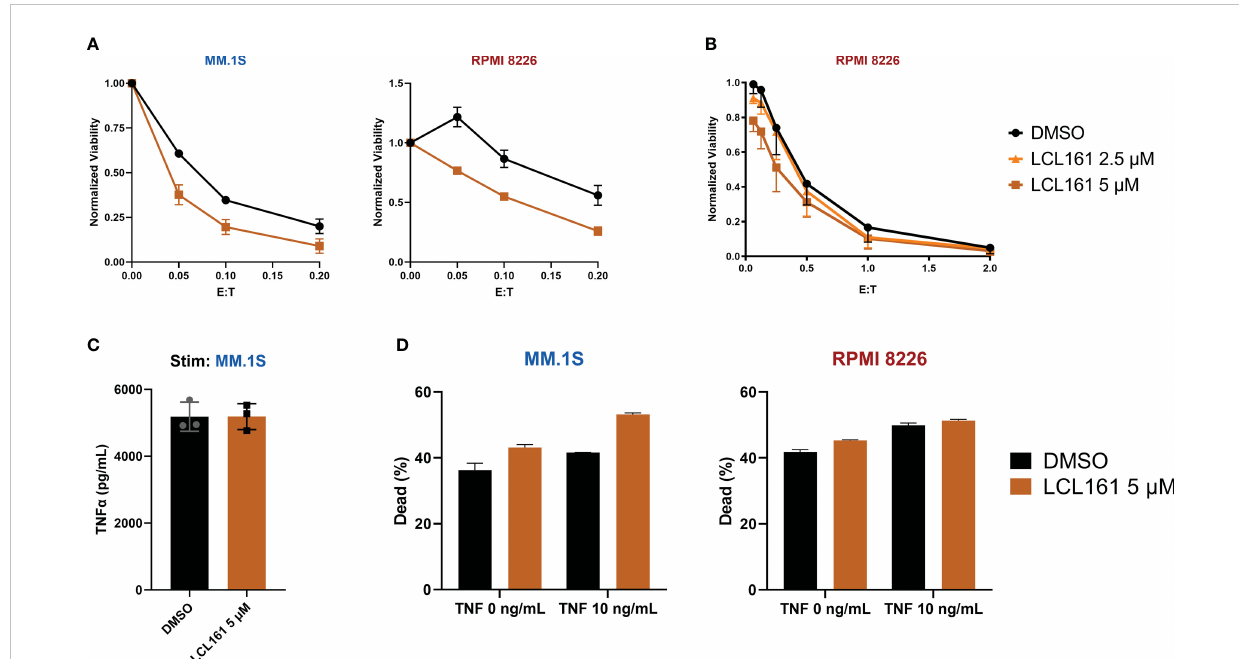
FIGURE 5 LCL161 sensitizes multiple myeloma cells to T cell cytotoxicity at higher doses. (A) 5x10 5 tumor cells were co-cultured with TAC T cells and 5 m M LCL161 or vehicle, in biological triplicate at various E:T for 24 hrs. After co-culture, cytotoxicity was measured through fl ow analysis and normalized to tumor-only controls; data shown as mean and SD. Data were generated with T cells from 3 different donors (L5, L6, L9) run independently in 1 experiment (B) . Luciferase-based cytotoxicity assay of TAC T cells co-cultured with effLuc+ myeloma cell lines for 48 hours in the presence of vehicle or LCL161. Samples were run in triplicate and normalized to tumor-only cell controls; data shown as mean and SEM. Data were generated with T cells from 3 different donors (L6, L7, L9) run independently in 1 experiment. (C) TAC T cells were stimulated with MM.1S cells at an E:T ratio of 1:1 in the presence of either DMSO or LCL161 for 24 hours and TNF a levels were measured in the supernatant. The data re fl ects technical triplicates (D) Multiple myeloma cell lines were incubated with DMSO or LCL161, in the presence of TNF a for 48 hrs. Cells were harvested, stained for